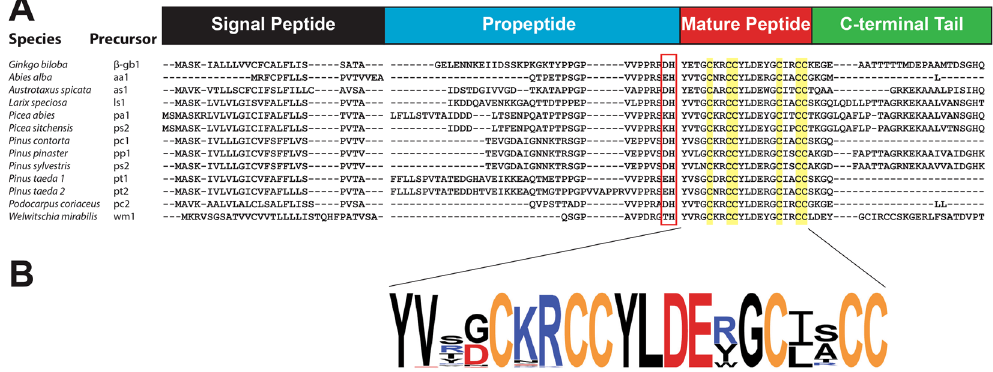
Figure 8. Precursor sequences alignment of β -ginkgotide β - gb1 and twelve selected β -ginkgotide-like peptides. ( A ) The precursors are divided into four major domains, including a signal peptide, a propeptide, a mature peptide and a C-terminal tail. ( B ) The mature peptides of 76 β -ginkgotide-like peptides were summarized as a Weblogo. The cysteine, positive and negative charged residues were highlighted with yellow, blue and red, respectively.